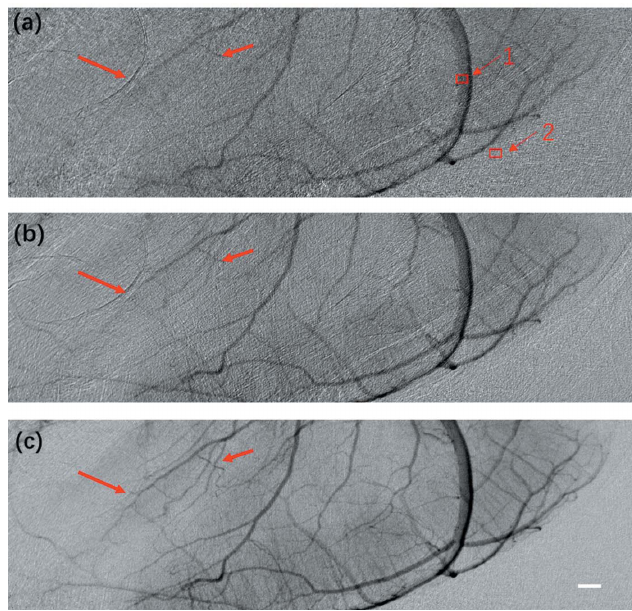
Figure 6 Images of blood vessels with less than a quarter of the photon flux obtained using ( a ) the temporal subtraction method, ( b ) conventional averaging with 10 frames, and ( c ) PTA with a window width of 19. Scale bar: 0.5 mm.